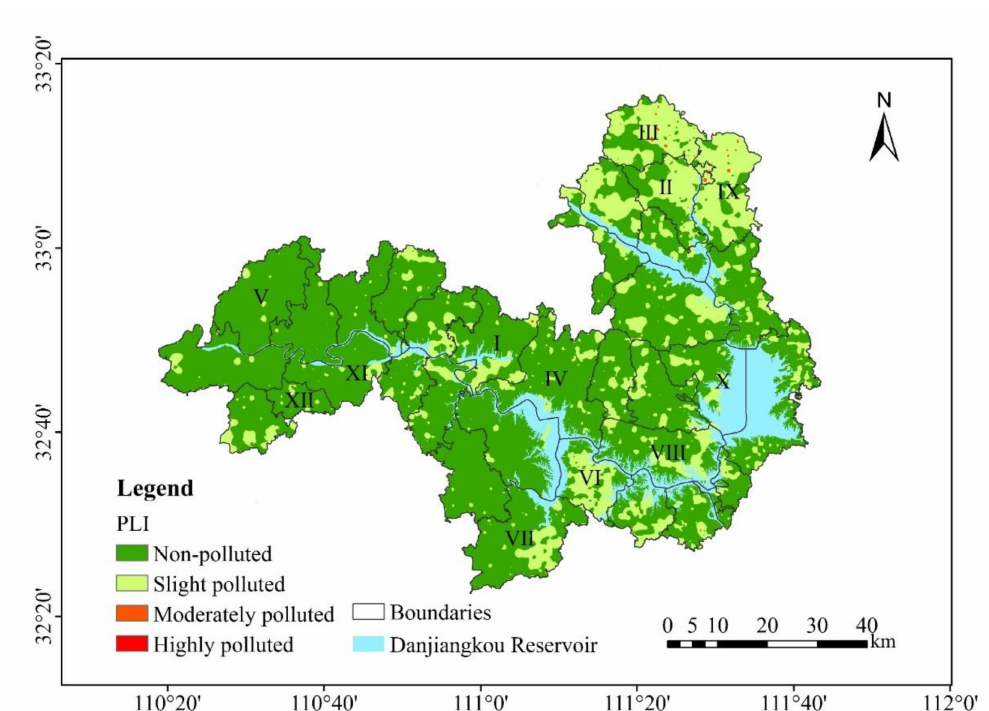
Figure 5. Spatial distribution of PLI for heavy metals in topsoil of the study area. I: Anyang Town; II: Jinhe Town; III: Maotang Town; IV: Xijiadian Town; V: Hejia Town; VI: Longshan Town; VII: Wudang Mountains, D.C.; VIII: Liangshuihe Town; IX: Shangji Town; X: Cangfang Town; XI: Liubei Town; XII: Fangtan Town.